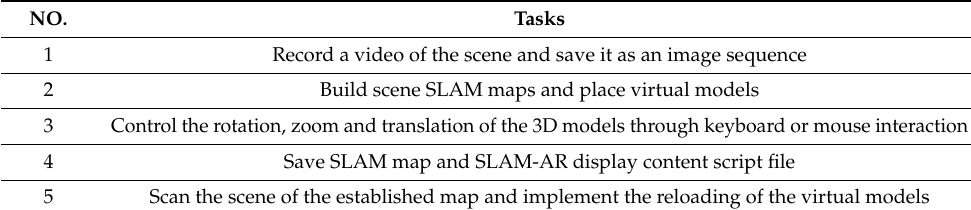
Table 4. AR registration task based on SLAM map